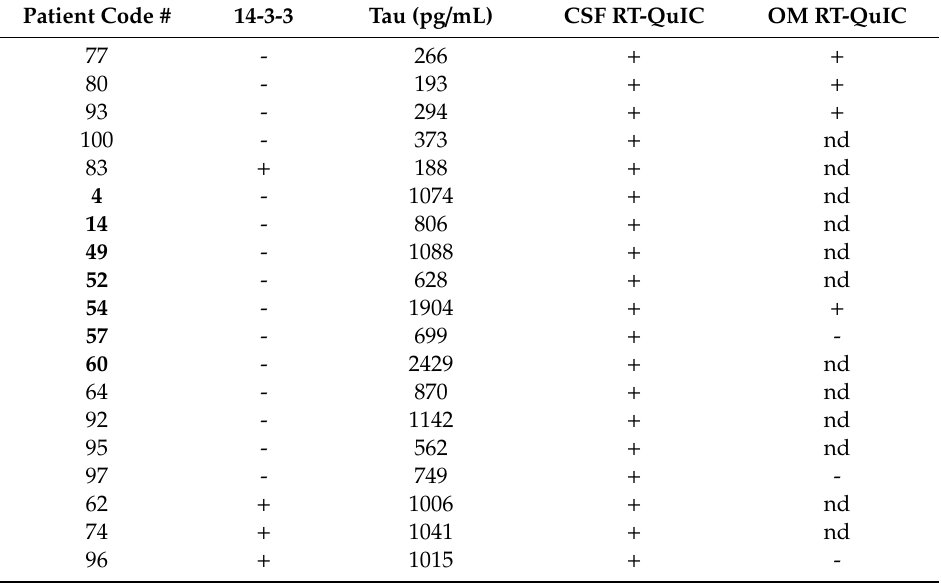
Table 4. Probable and definite sCJD with misleading 14-3-3 and tau testing (in bold are the definite